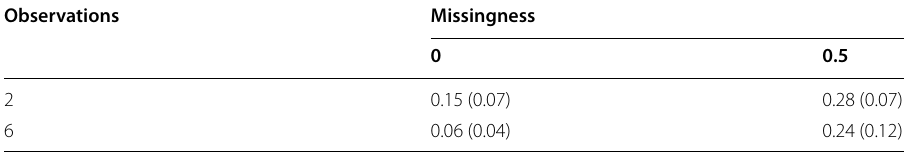
Median and IQR of RMSE for model parameter recovery by proportion of missing data and mean number of observations per agent